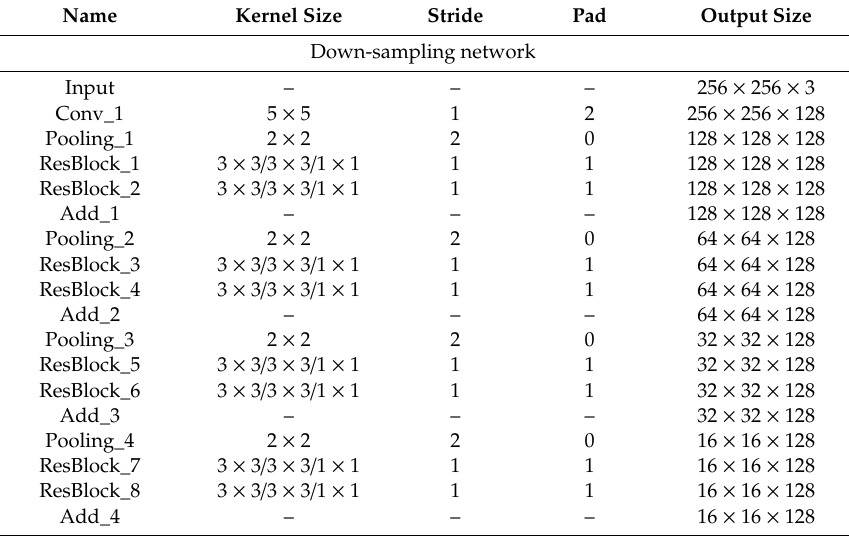
Table 1. The architecture of the proposed DeepResUnet network.